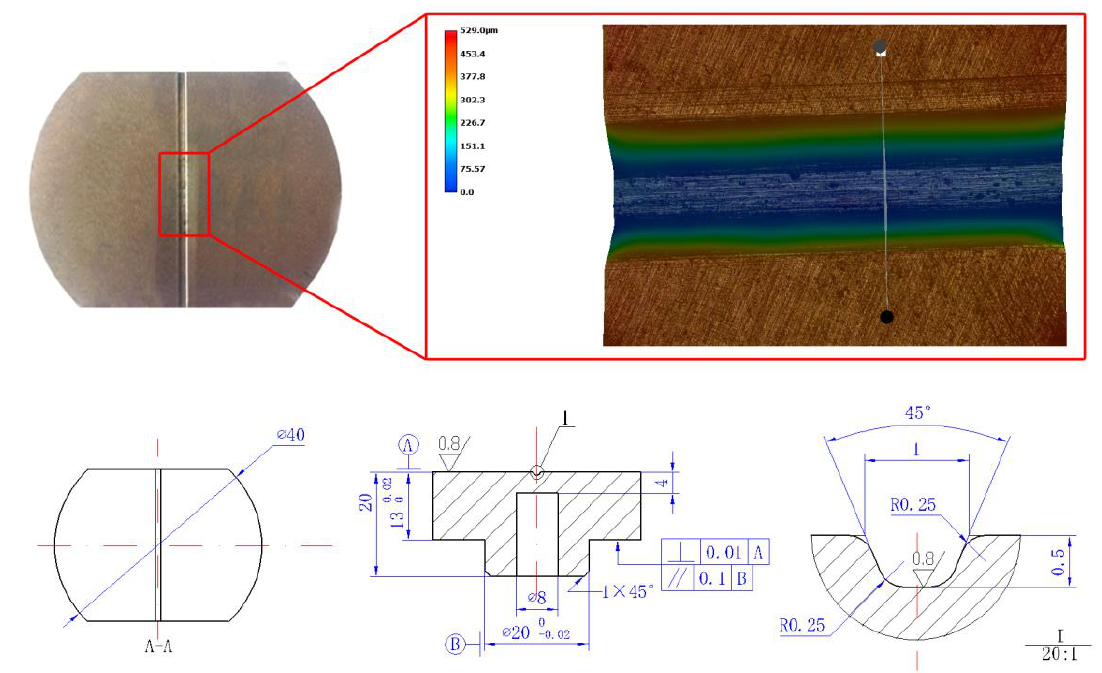
Figure 2. The graphic and engineering drawing of the rigid die.